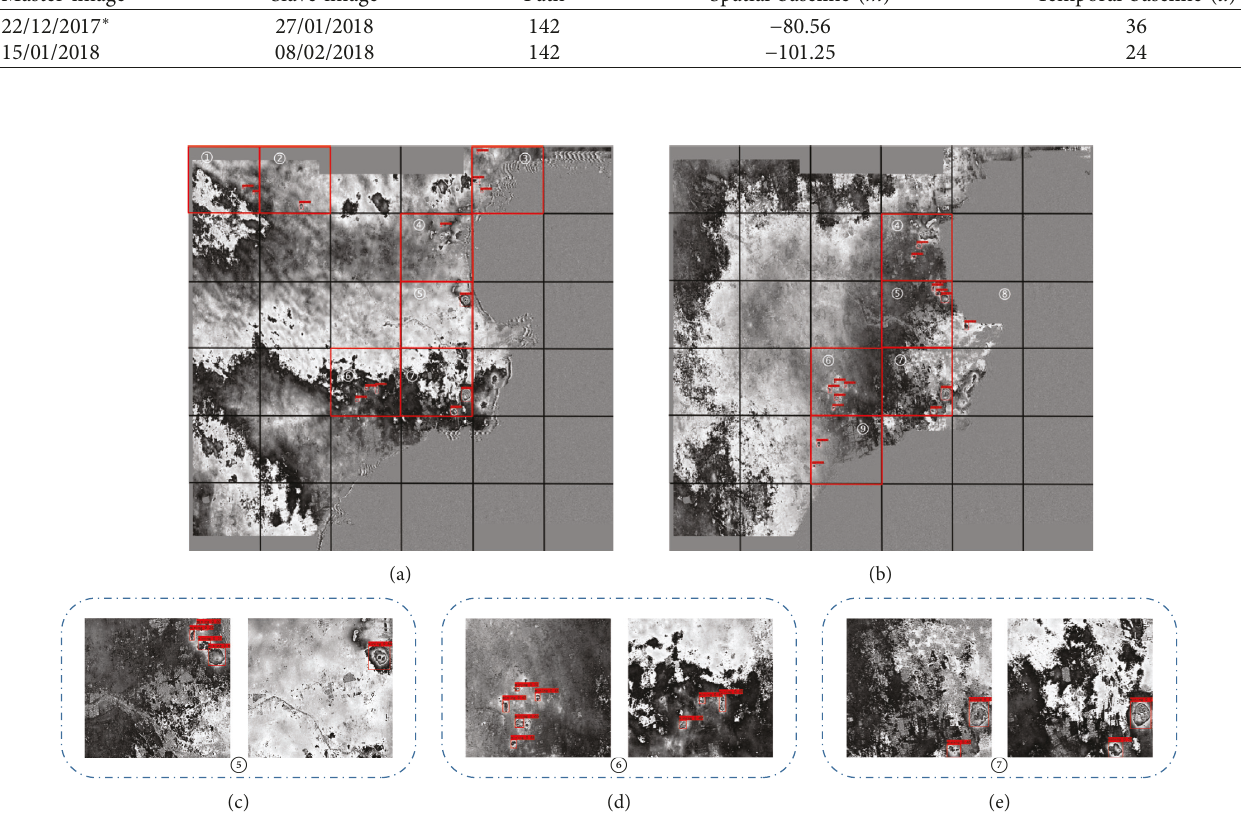
Figure 6: Detection results of subsidence areas. (a) Detection results from 10/01/2018 to 23/03/2018 interferometric pair; (b) detection results from 13/10/2018 to 24/12/2018 interferometric pair. The results of (c) Hongguang village ⑤ , (d) Zhanhua district ⑥ , and (e) Xianhe town ⑦ are enlarged,